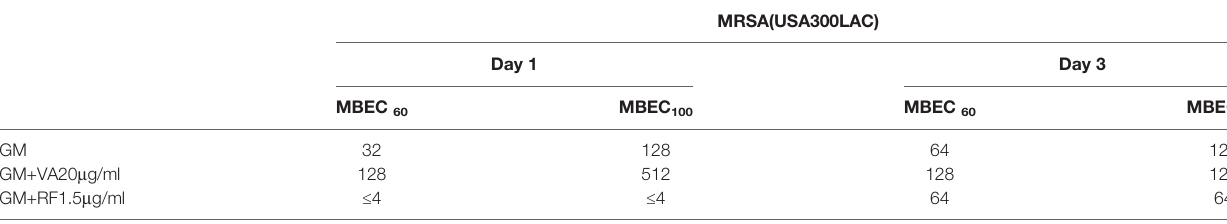
TABLE 4 | Additional effect of second antibiotics in systemic dose on in vitro MBEC of GM.